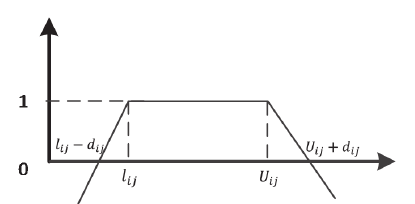
Fig 5. The membership function used in µ calculation